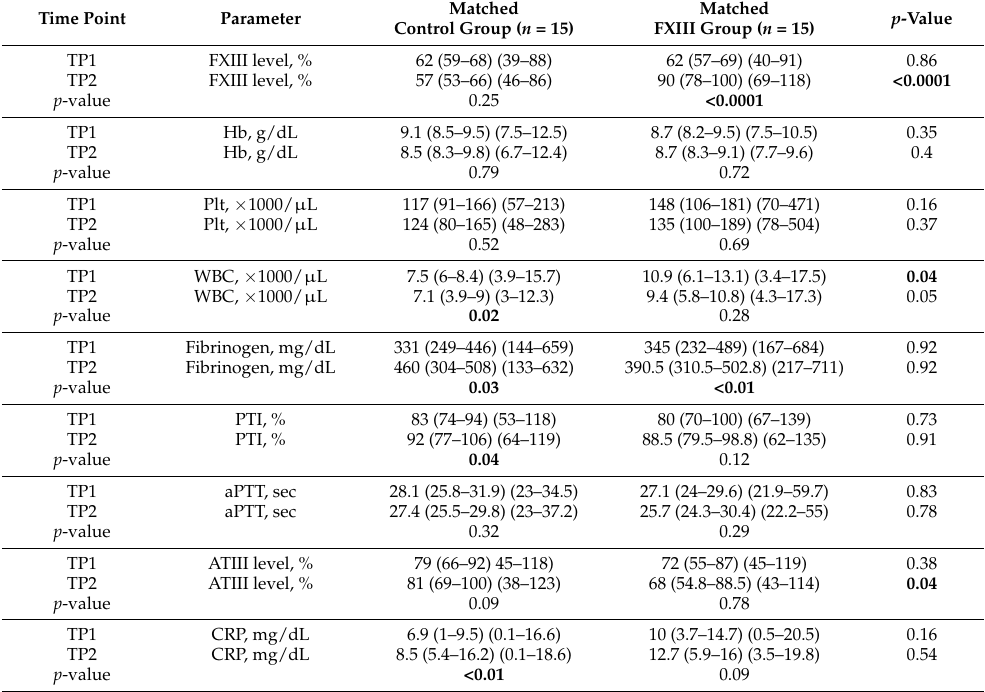
Table A3. Laboratory parameters of 30 patients in the matched cohorts at the two consecutive time